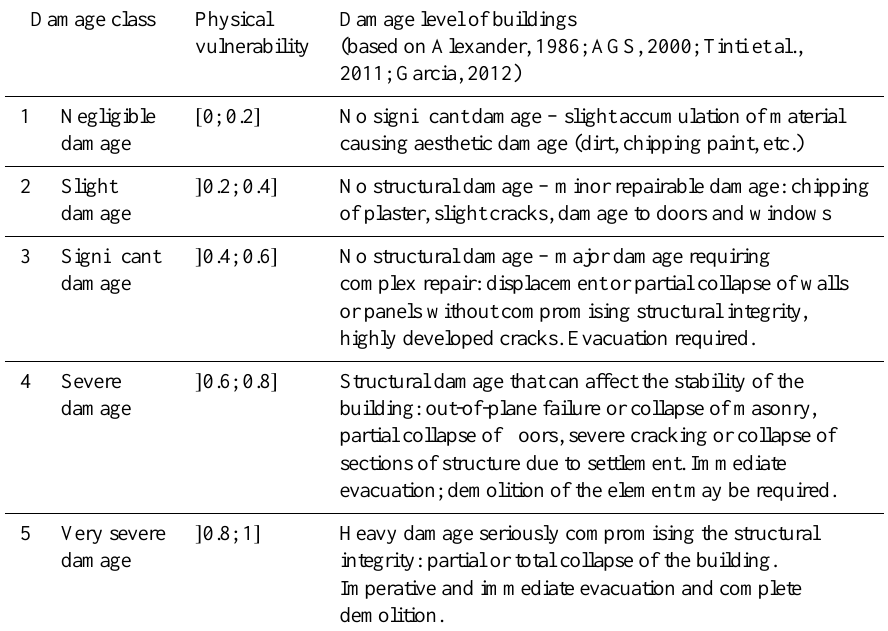
Table 2. Damage level of